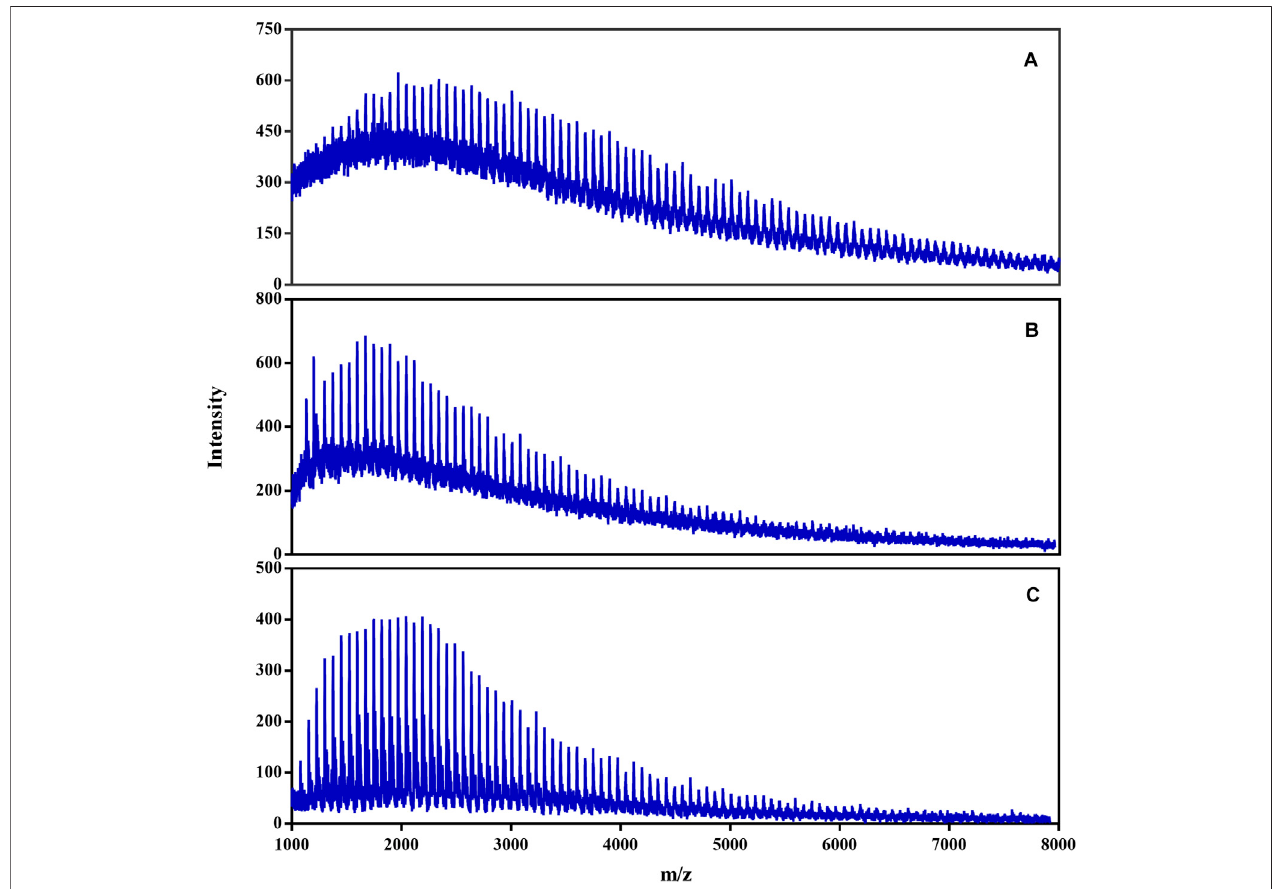
FIGURE2| MALDI-TOFMSof30cPhydroxylsiliconeoilwiththedifferentmatrix:A)DHB,B)pyridine-modi fi edDHB,C)pyridine-modi fi edDHBwiththeadditionof NaAc.